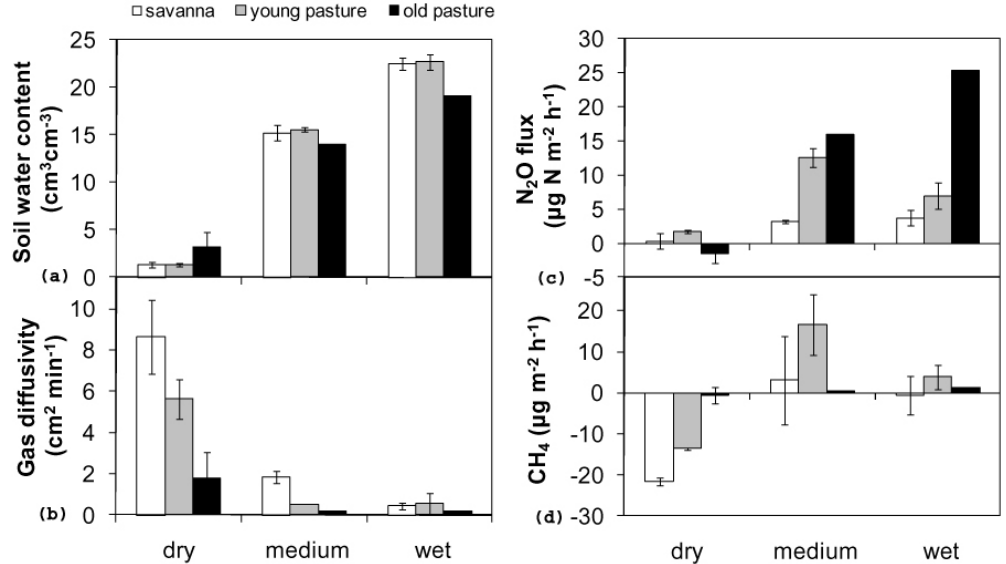
Fig. 5. The effect of artificially increased soil water contents (a) upon soil gas diffusivity (b) and soil CH 4 (c) and N 2 O (d) fluxes. White bars are savanna woodland, grey bars are young pasture and black bars are old pasture. Standard error bars ( n ≤ 3) are indicated. Table 4. Seasonal and annual cumulative fluxes of CO 2 , N 2 O and CH 4 for each land use, calculated from manual chamber flux data. Note that CO 2 is in tonnes (tCO 2 -Cha − 1 y − 1 ) while N 2 O and CH 4 are in kilograms (kgN 2 O-Nha − 1 y − 1 , kgCH 4 -Cha − 1 y − 1 ). The final row is in CO 2 -equivalent units (tha − 1 y − 1 ). CO 2 N 2 O CH 4 Season Savanna Young pasture Old pasture Savanna Young pasture Old pasture Savanna Young pasture Old pasture Dry-wet transition 3.34 4.53 5.95 0.00 0.01 Annual sums 14.55